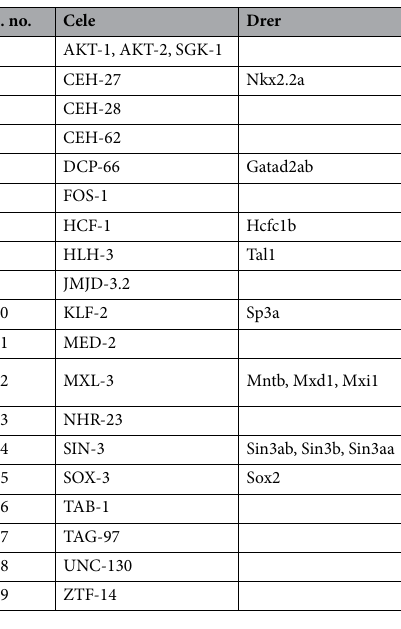
Table 3. Caenorhabditis elegans SIN-3 protein interactors conserved in SIN3 interactome of other model organisms (Cele, Caenorhabditis elegans Hsap, Homo sapiens ; Mmus, Mus musculus ; Drer, Danio rerio ; Dmel, Drosophila melanogaster ; Scer, Saccharomyces cerevisiae